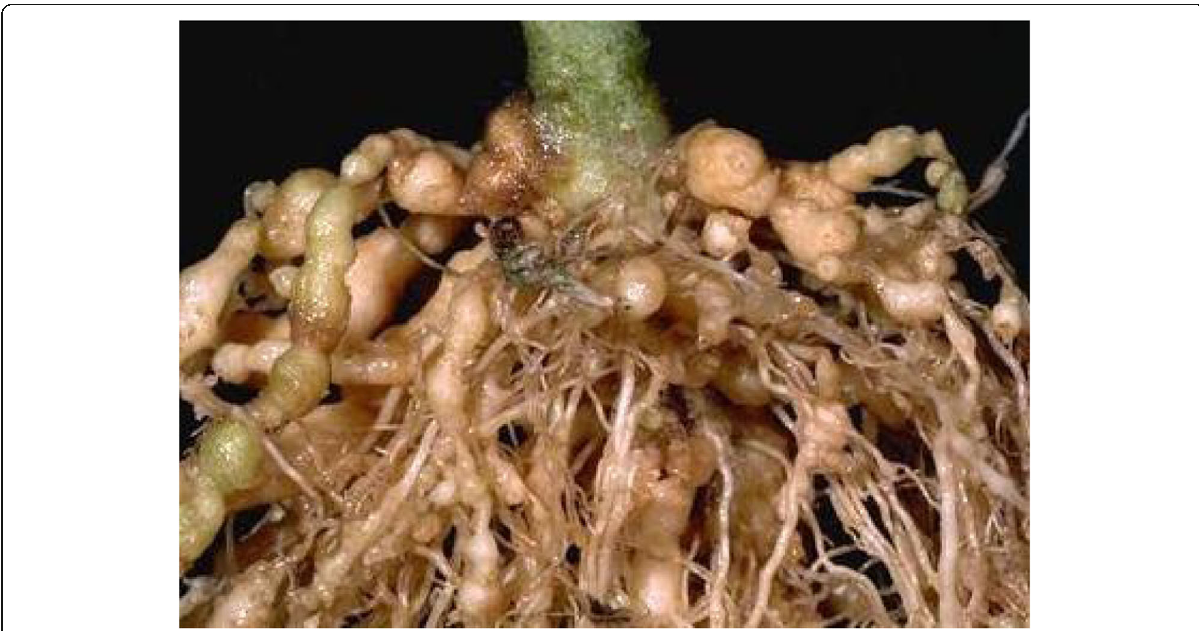
Fig. 2 Close-up view of root-knot nematode ( Meloidogyne spp.) inducing different gall sizes of tomato